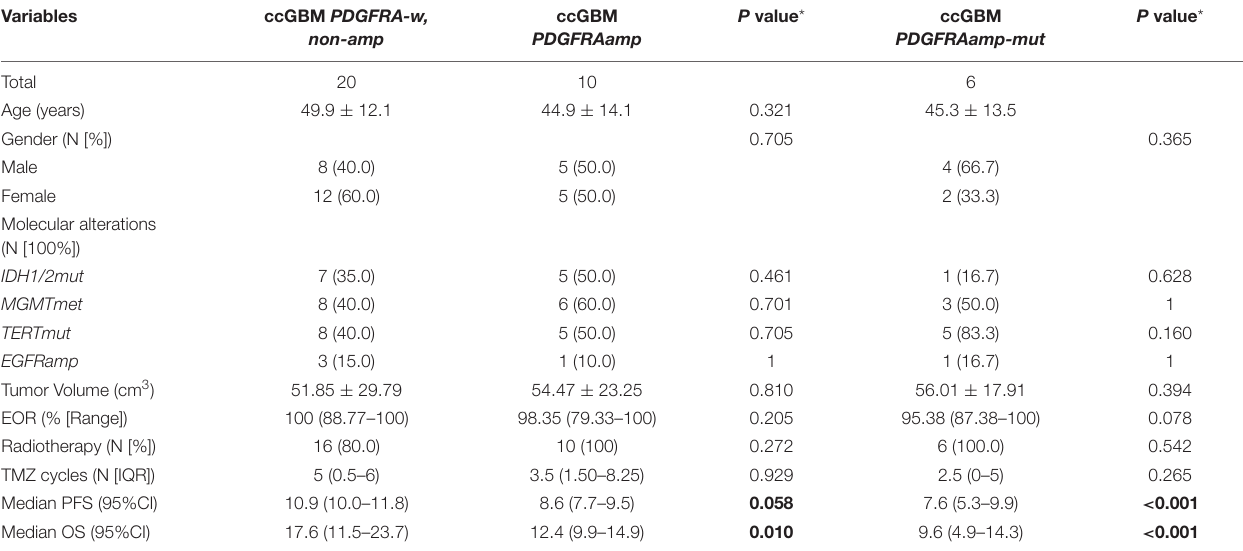
TABLE 4 | Comparison of ccGBM in different PDGFRA alteration